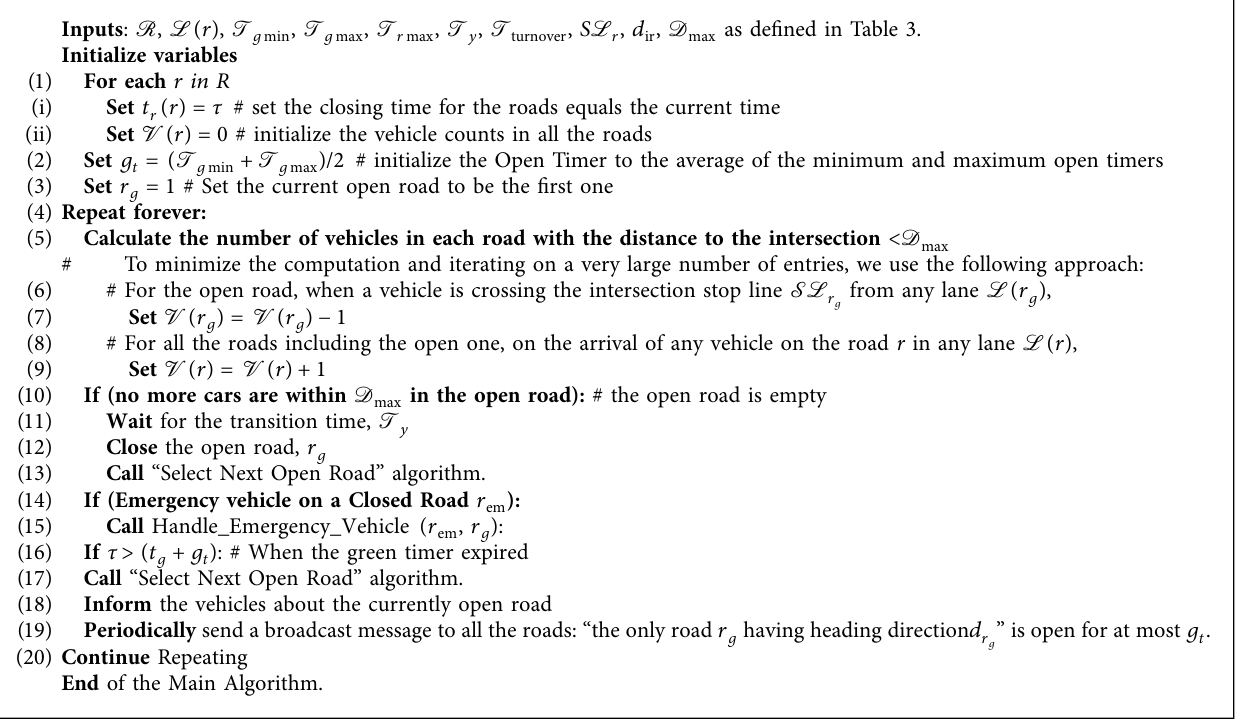
A LGORITHM 1: Proposed adaptive traffic management